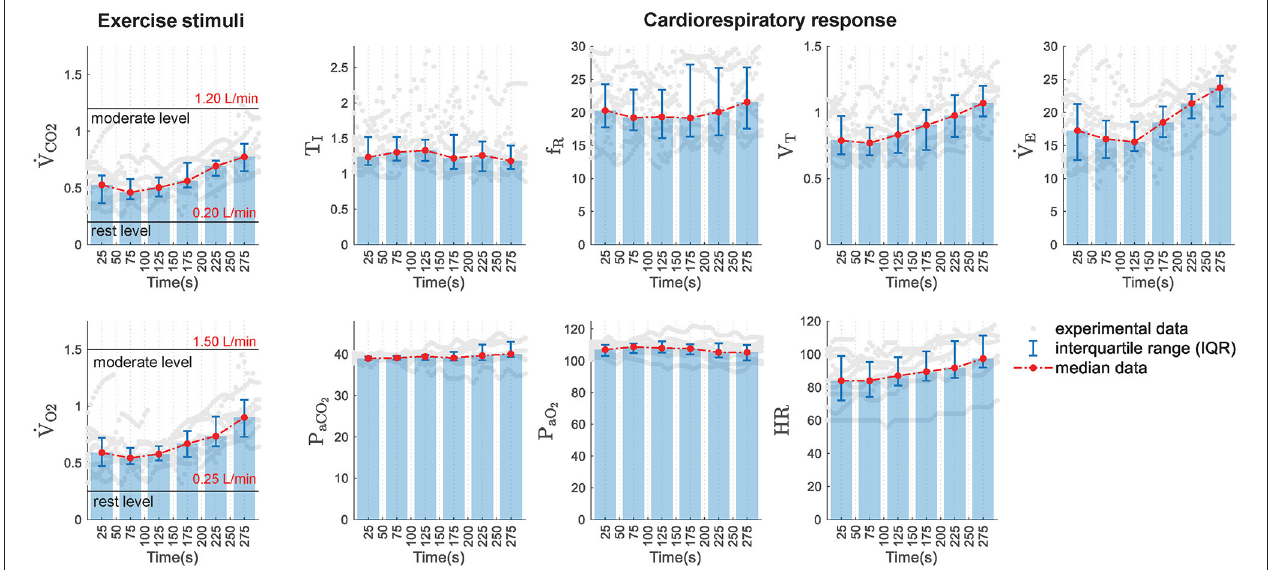
FIGURE 1 | Experimental data distribution in function of time. (Left) Experimental exercise stimuli used to simulate the models under study: ventilated values of CO 2 ). Rest and moderate exercise levels are also marked in both variables. (Right) Experimental data of the cardiorespiratory variables analyzed: ) and O 2 ( ˙ V O ( ˙ V CO 2 2 inspiratory time ( T I ), respiratory frequency ( f R ), tidal volume ( V T ), minute ventilation ( ˙ V E ), arterial partial pressure of CO 2 ( P aCO Gray dots show original experimental data, bar plots and red lines display the median values obtained in 50-s consecutive time intervals and error bars show the interquartile ranges calculated in each